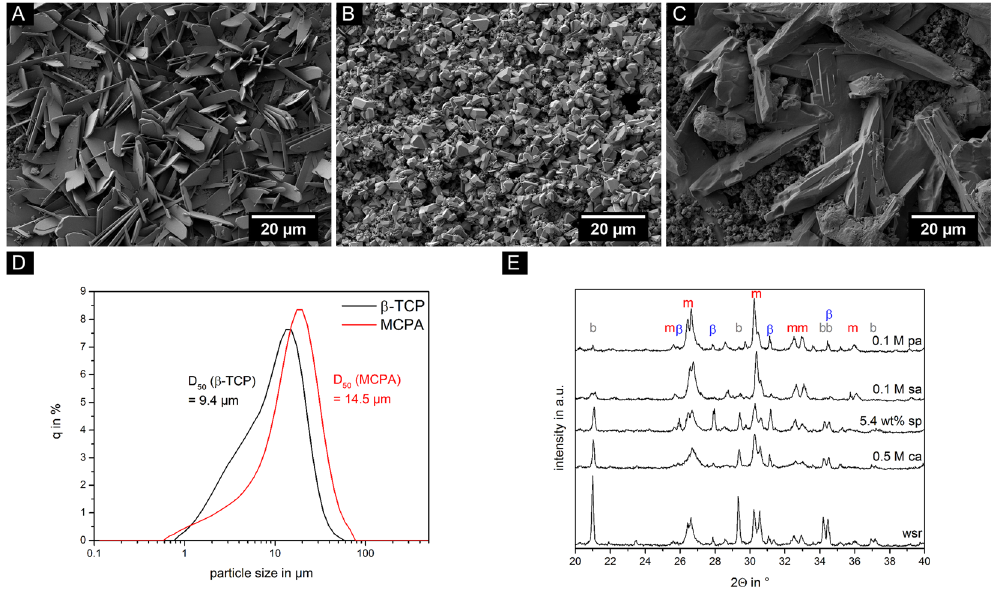
Figure 7. SEM images of three different types of morphology taken at 3 kV and 2000-fold magnification. Images show plates ( A ), plate-like crystals ( B ) and needles ( C ). The cements with 0.1 M sulfuric acid ( A ), no setting retarder ( B ) and 0.5 M citric acid ( C ) served as examples. The particle size distribution of the reactant powders β -TCP and MCPA are shown ( D ). Both had a monomodal particle size distribution between 1 µ m and 100 µ m. Analysis of phase composition via XRD ( E ) exhibited crystalline structures for brushite (b), monetite (m) and the reactant powder β -TCP ( β